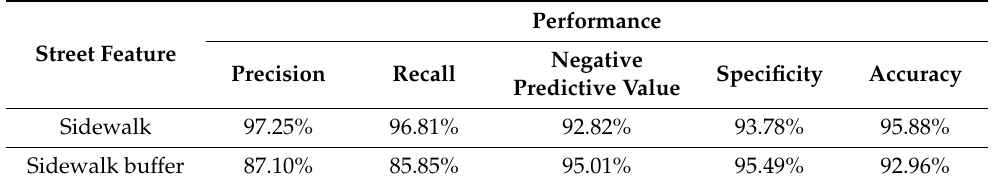
Table A1. Validation performance of image classifiers in pooled dataset including Phoenix AZ,